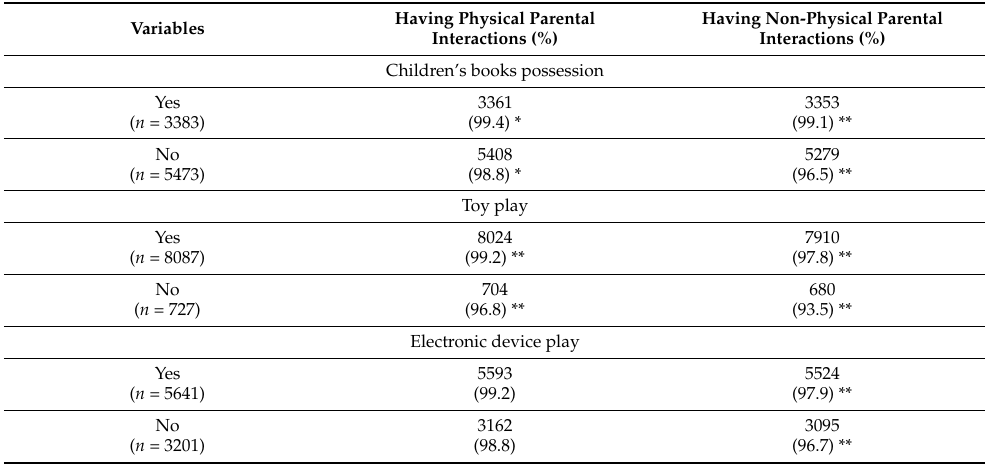
Table 4. Children’s books possession, toy play, and electronic device play, and having two types of parental